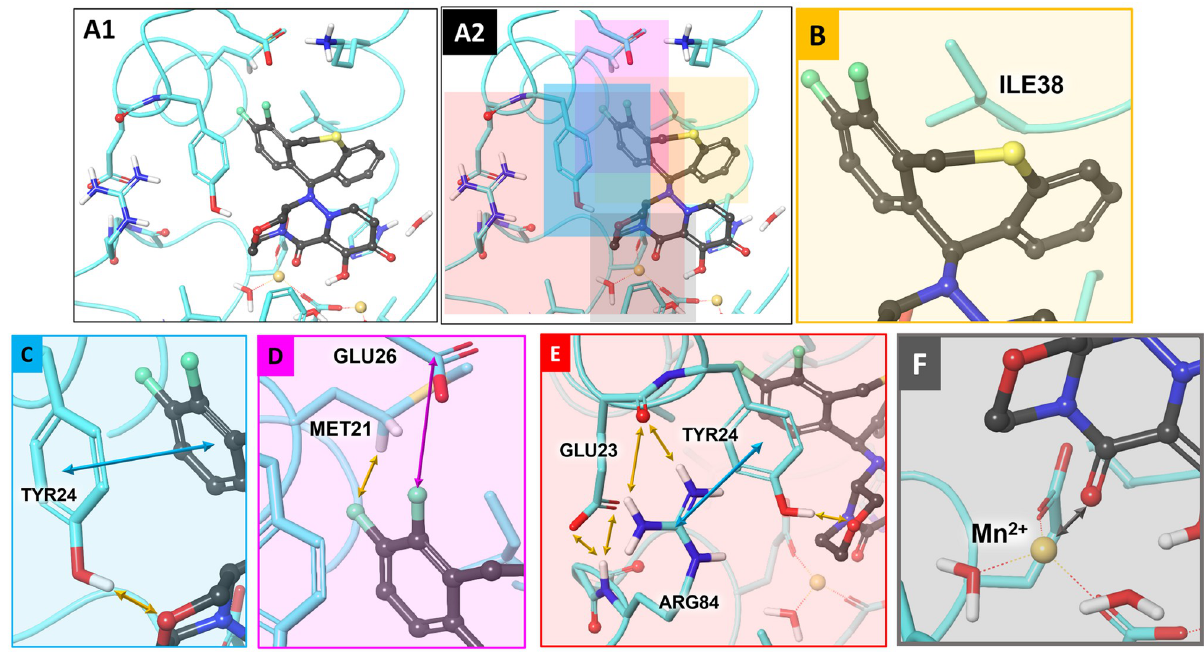
Fig 6. Predicted poses describing key BXA-rPA N interactions of WT A(H1N1)pdm09. A1, A2) Overall view of the BXA binding interface. B) Multiple hydrophobic contacts between the S-containing tricyclic system and the Ile38 residue. C) A hydrogen bond (HB) between the phenol H-atom of the Tyr24 residue and the morpholine O atom of BXA, and π -stacking between the Tyr24 phenyl ring and the fluorinated phenyl ring of BXA. D) A T-shaped orthogonal multipolar interaction between the second fluorine at the o-position and the carboxyl C atom of Glu26 (COO). E) The HB- stabilized cluster of Glu23 and Arg84 that co-stabilizes π -stacking and/or π -cation interaction between Arg84 and Tyr24. F) BXA coordination by Mn 2+ within the lower BXA tricyclic ring. Yellow arrows: hydrogen bonds; blue arrows: π -stacking interaction; pink arrows: halogen bonding; gray arrows: metal–ligand coordinating bond; dark-gray balls and sticks: BXA pose (pdb: 6FS6).